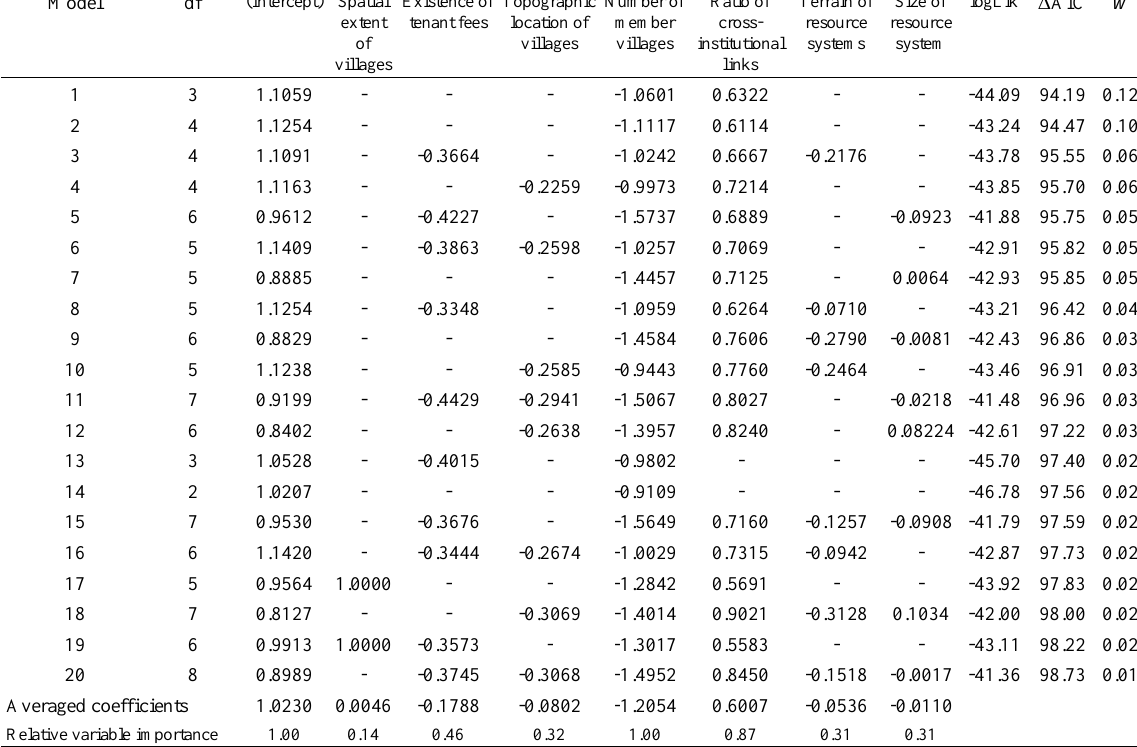
Table 4. Plausible models identified by the AIC method. For each model, the table indicates the coefficient of the variables included, the number of parameters (df), log-likelihood (logLik), delta weight ( ∆ AIC, difference between the AIC for a given model and the AIC of the best-fitting model), and Akaike weights ( w , the model selection probability). Averaged coefficients and the relative variable importance are also presented. The Akaike weight is the probability that a model would be selected as the best-fitting model if the data were collected again under identical circumstances. Model averaged estimates are weighted by their Akaike